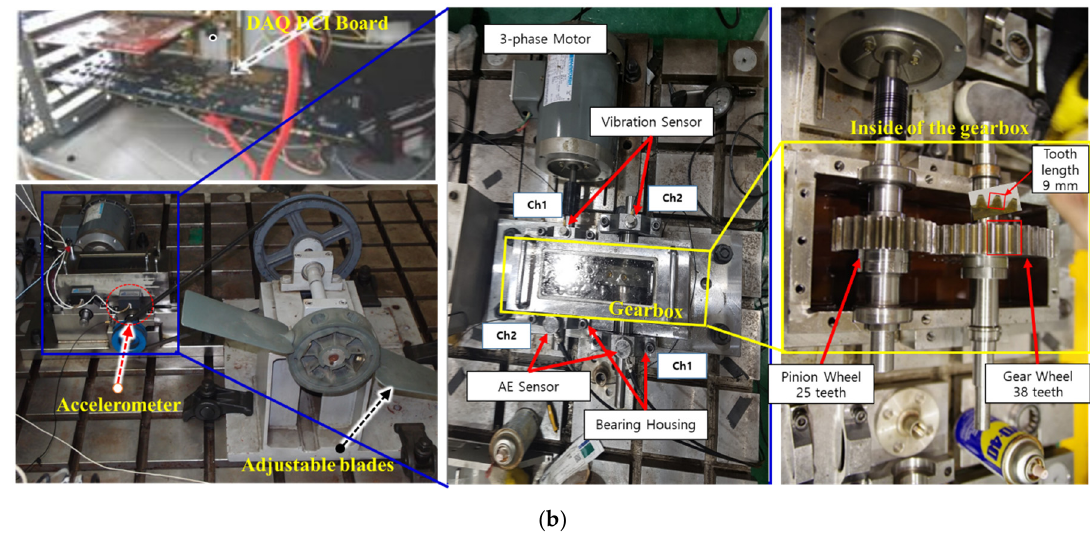
Figure 3. Experimental testbed setup: ( a ) function block diagram; ( b ) actual experimental assembly.